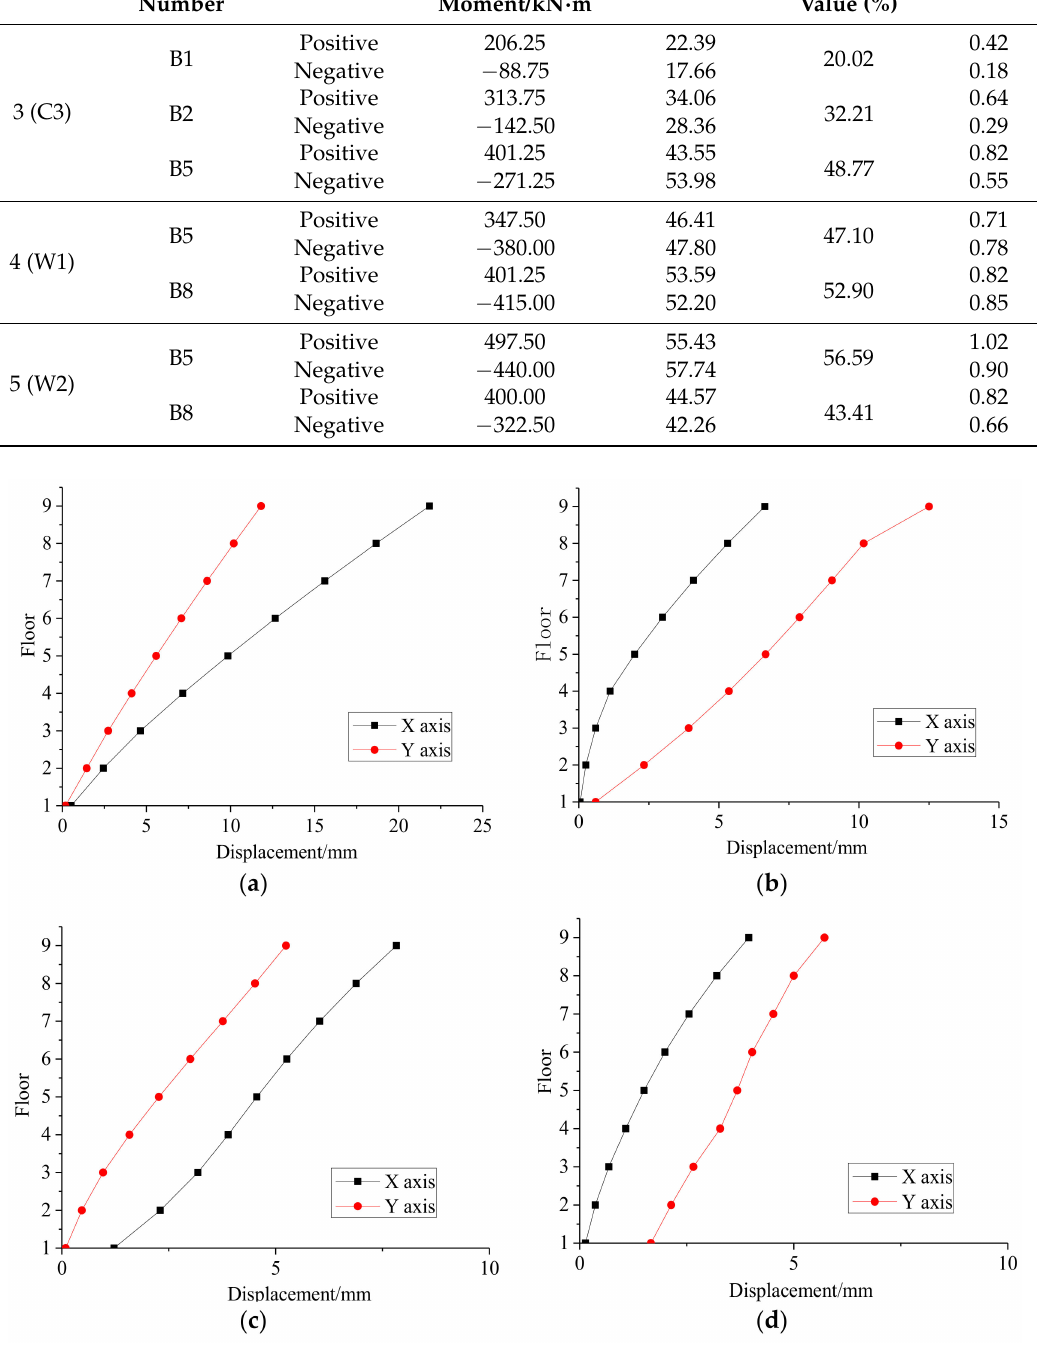
Figure 16. Displacement of structure in ( a ) case 2, ( b ) case 3, ( c ) case 4 and ( d ) case